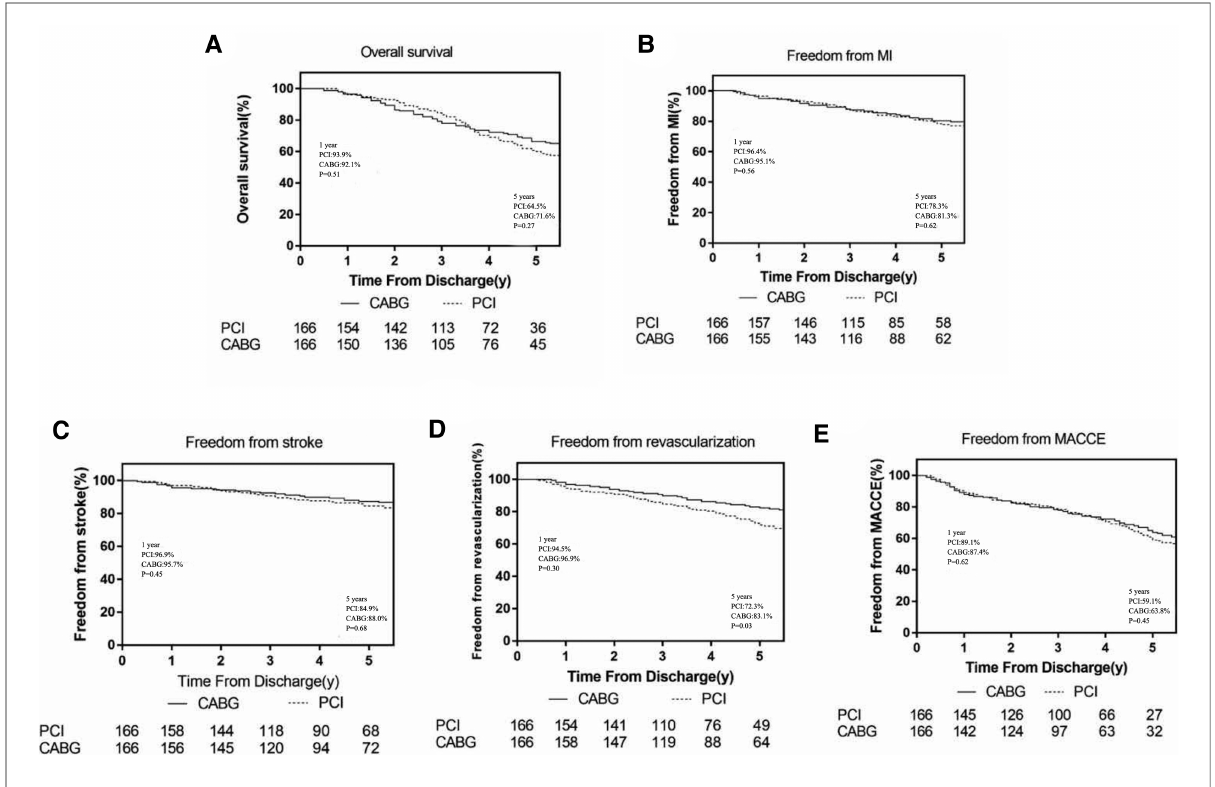
FIGURE 1 The comparison of survival and MACCEs at 1-year and 5-years between the two